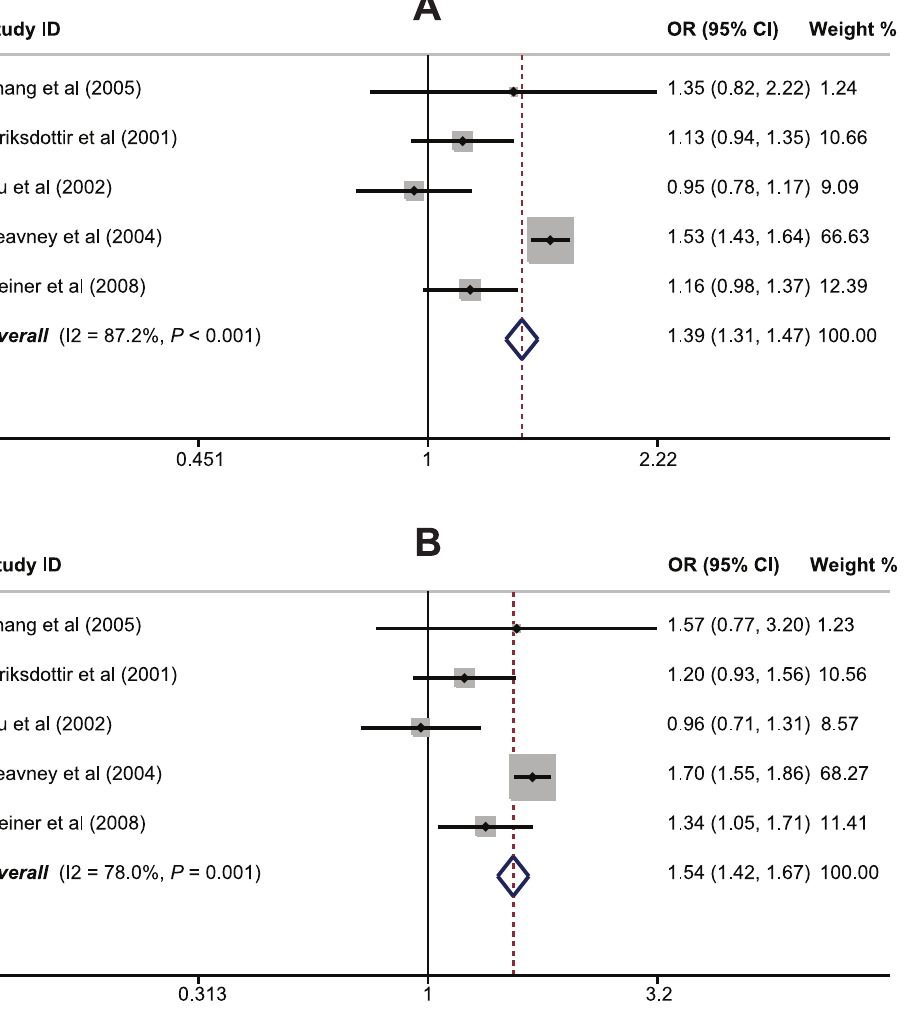
Figure 2. Forest plot of the relationships between CETP rs708272 (C . T) polymorphism and myocardial infarction risk under the allele and dominant